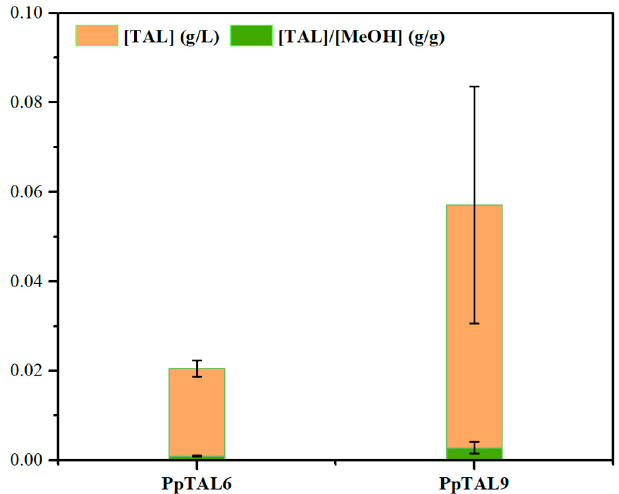
Figure 5. TAL production from methanol in P. pastoris . Comparison of TAL titer of PpTAL6 and PpTAL9 in SCM medium. MeOH, methanol. The data represent three biological replicates, and the error bars represent standard deviations.